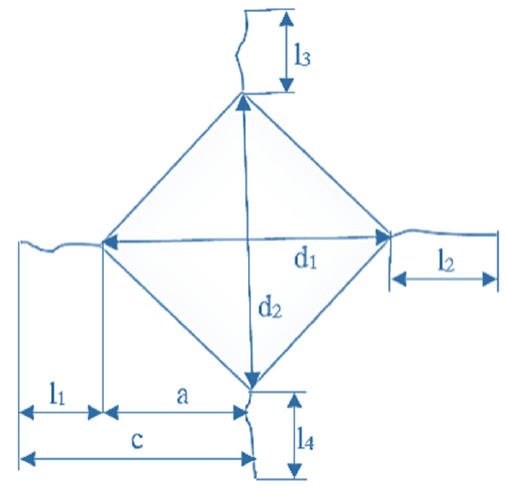
Figure 4. The characteristic values used to calculate the Vickers indentation fracture toughness ( K IC ) of brittle materials.